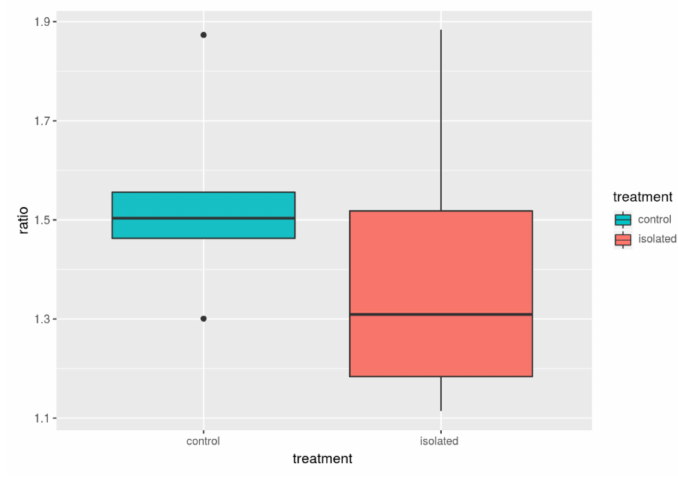
Figure 1. F/B ratio between control and isolated animals.